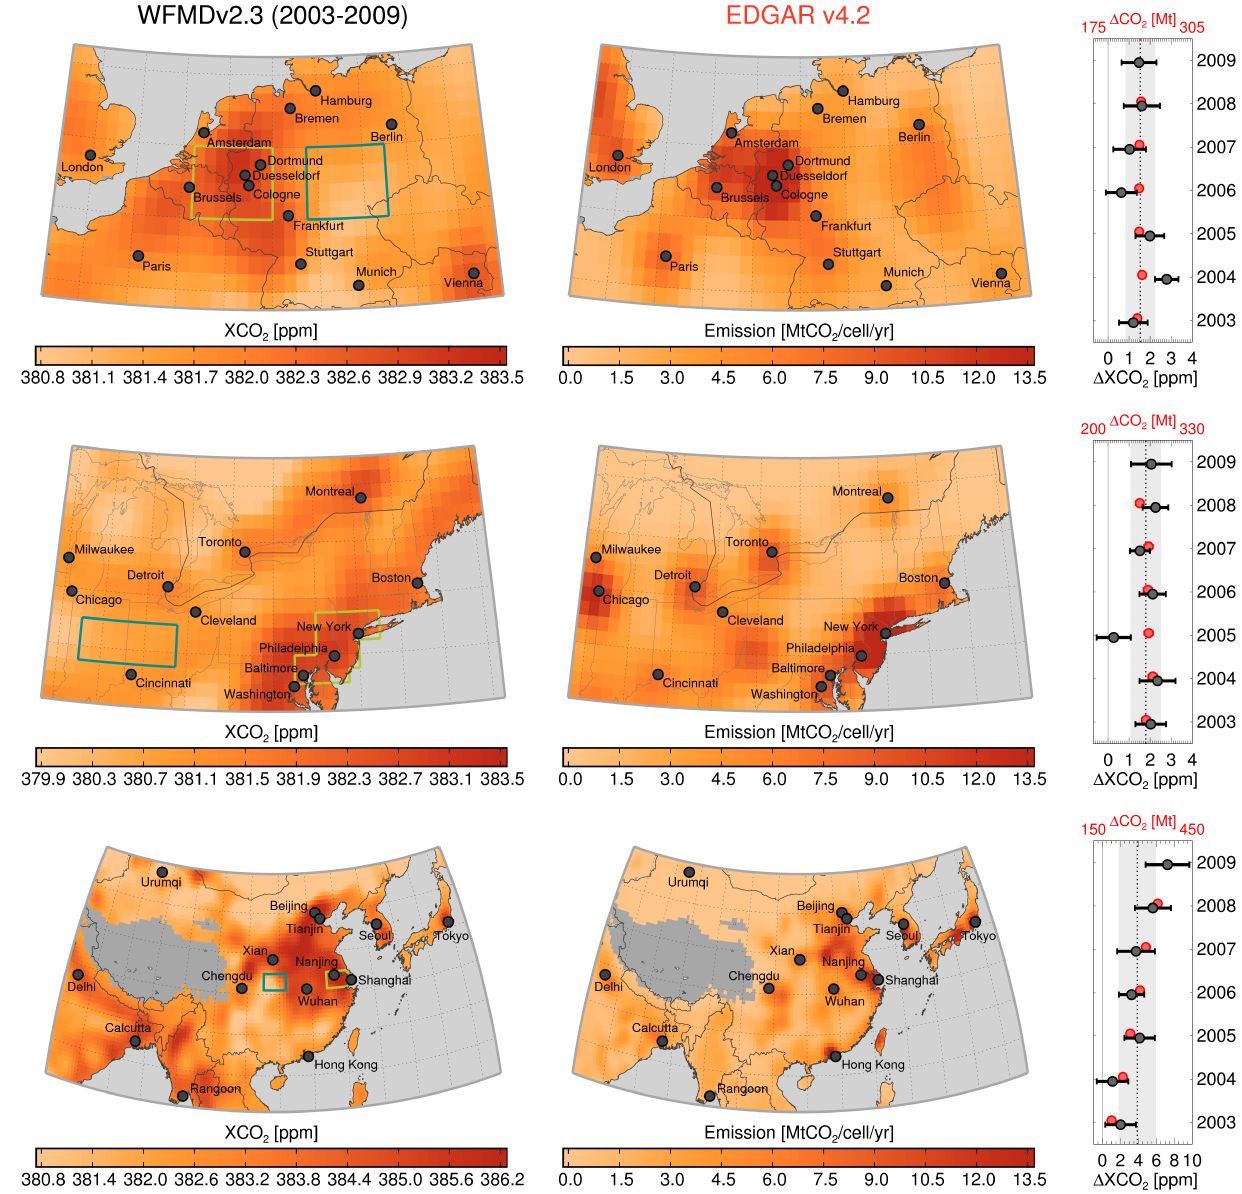
Fig. 2. SCIAMACHY XCO 2 (left) and EDGAR anthropogenic CO 2 emissions (middle) for several regions. To quantify the regional XCO 2 enhancement source and background regions are defined, respectively (yellow and teal polygons). The yearly enhancements shown as sym- bols in the right panel are defined as the yearly mean value of the background region subtracted from the mean value of the source region using the root sum square of the corresponding standard deviations as error bars. The dotted lines represent the mean enhancements aver- aged over all years and the shaded areas the corresponding standard deviations. Also shown are the yearly emission enhancements from the EDGAR database in